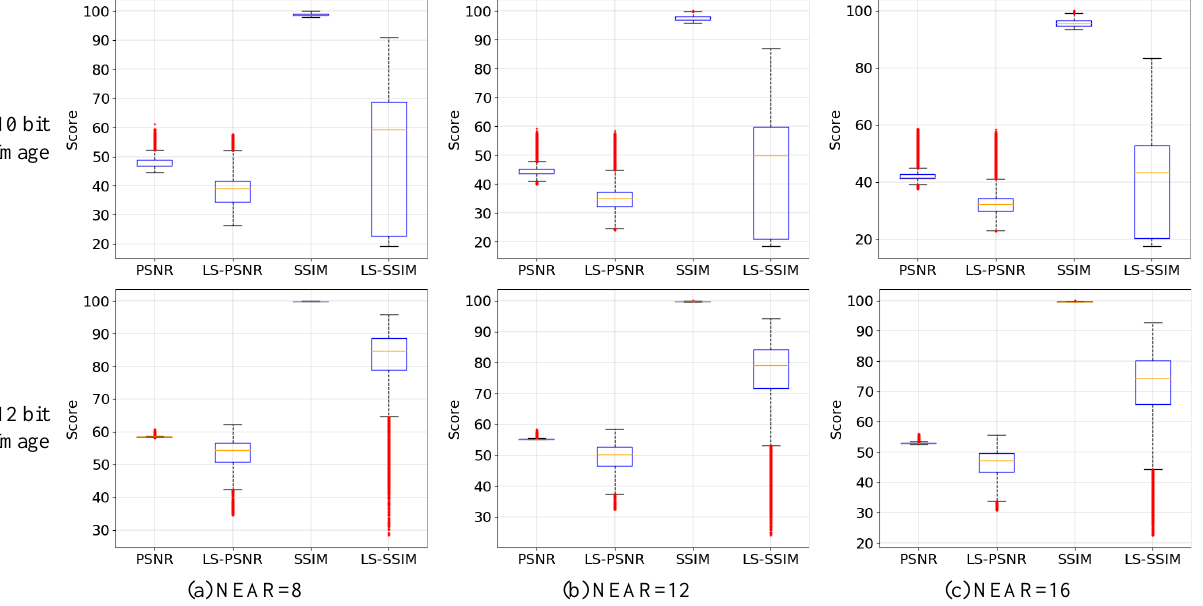
Figure 7. The predicted scores’ distribution of all R IQA models as box plots. In each box, the central orange mark represents the median, while the bottom and top edges of the box indicate the 25th and 75th percentiles, respectively. The whiskers extend to the most extreme data points not considered outliers, and the outliers are plotted individually using the ‘+’ symbol. Further, in order to compare the predicted scores’ distribution of different R IQA models at the same scale, we enlarged the predicted scores of SSIM and LS-SSIM by one hundred times to reach the same magnitude as PSNR and